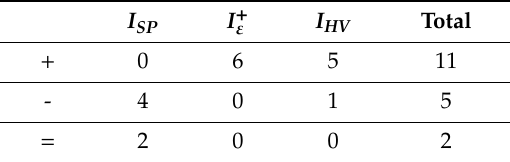
Table 6. SPEA2 pairwise comparisons—Wilcoxon test summary for the Van Zyl, Baghmalek, and Anytown